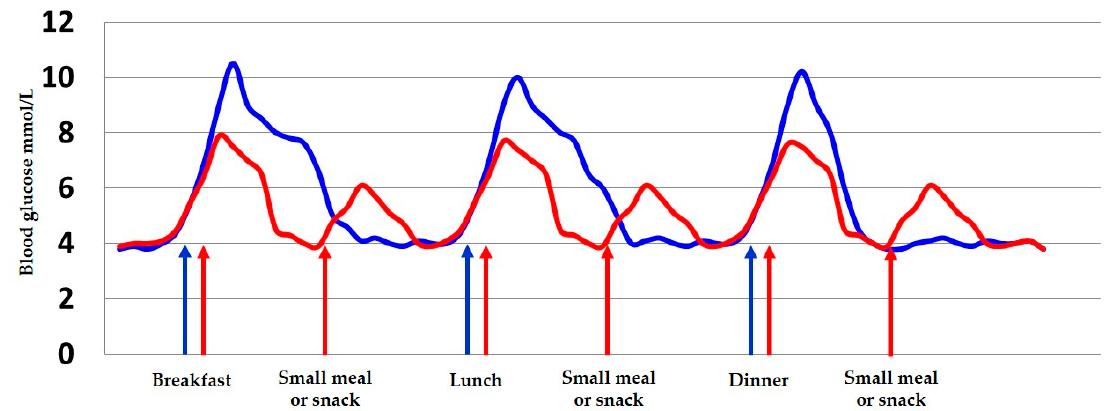
Figure 1. The blood glucose levels according to different strategies for daily food intake. Blue curve illustrates the normal meal pattern and red curve illustrates meal pattern in women with gestational diabetes mellitus (GDM) to avoid excessive blood glucose fluctuations and to preserve the planned number of calories to be ingested. Blue arrows: Three main meals. Red arrows: three main meals and three